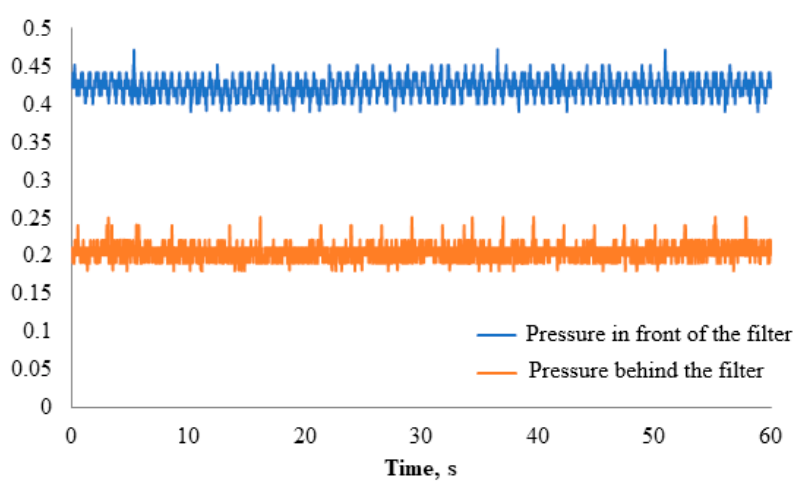
Figure 4. Plot of flow of uncontaminated oil with MANN W950/26 filter at 30 °C.